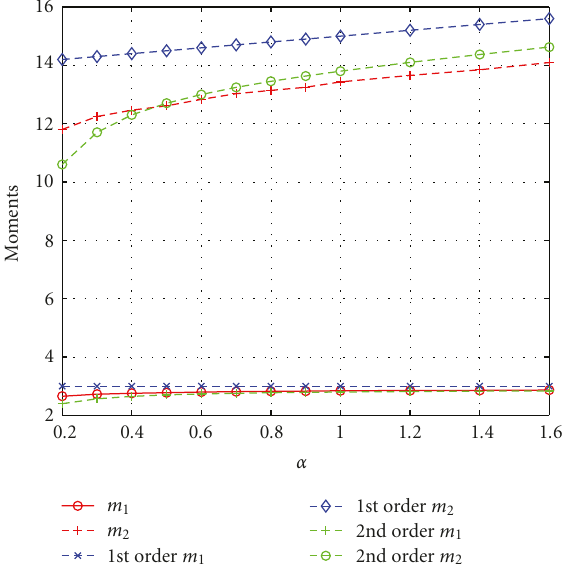
Figure 4: Performance versus various α.